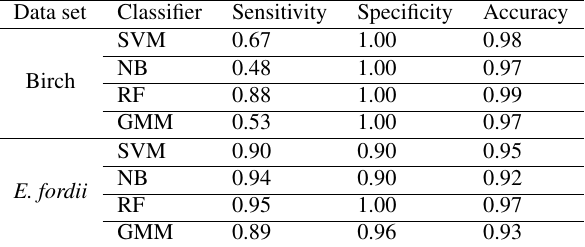
Table 5. Performances of all classifiers trained with a combined training set from both